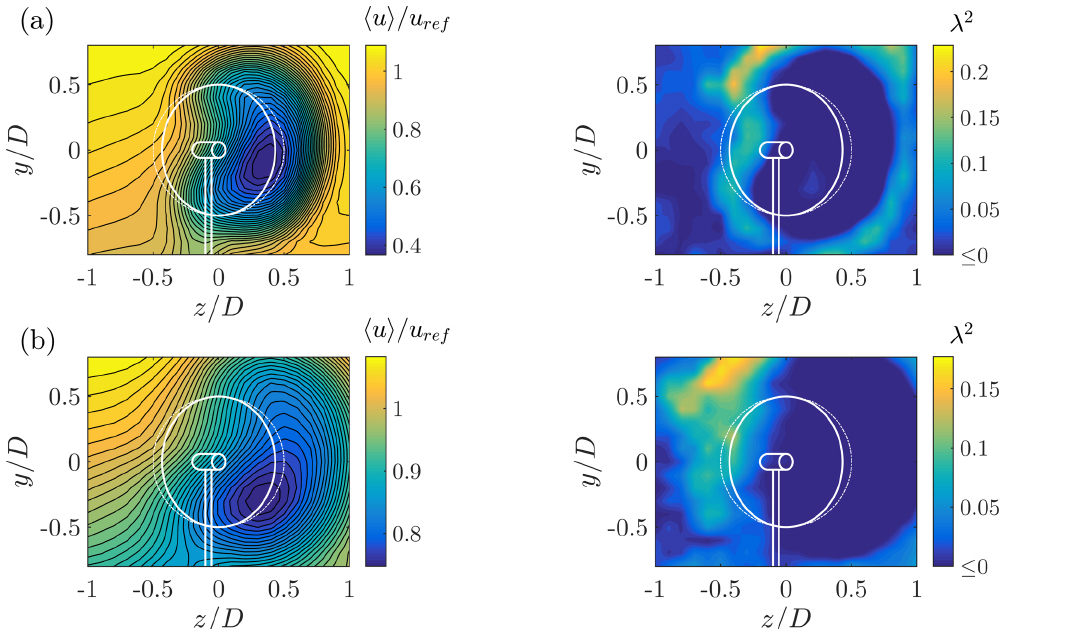
Figure B1. LES data of the wakes 3 D (a) and 6 D (b) behind the ForWind turbine at γ = 30 ◦ . In contrast to the experiments presented in this paper, the inflow in the LES domain features a vertical shear with comparable turbulence intensity. The timescales of τ for the λ 2 calculations correspond to the length scale of the rotor